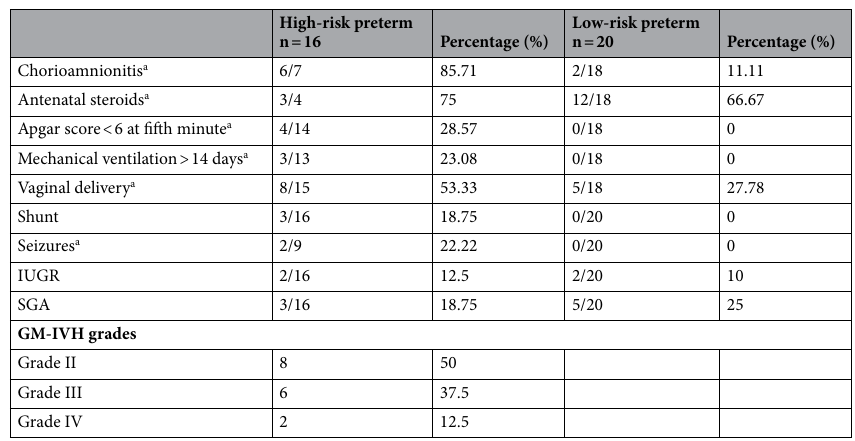
Table 1. Clinical data of high- and low-risk preterm samples. IUGR: intrauterine growth restriction; SGA: small for gestational age; and GM-IVH: germinal matrix-intraventricular hemorrhage. a Available data for chorioamnionitis: 7 High-risk preterm and 18 Low-risk preterm; antenatal steroids: 4 High-risk preterm and 18 Low-risk preterm; Apgar score < 6 at fifth minute: 14 High-risk preterm and 18 Low-risk preterm; mechanical ventilation > 14 days: 13 High-risk preterm and 18 Low-risk preterm; vaginal delivery: 15 High- risk preterm and 18 Low-risk preterm; and seizures: 9 High-risk preterm and 20 Low-risk preterm.